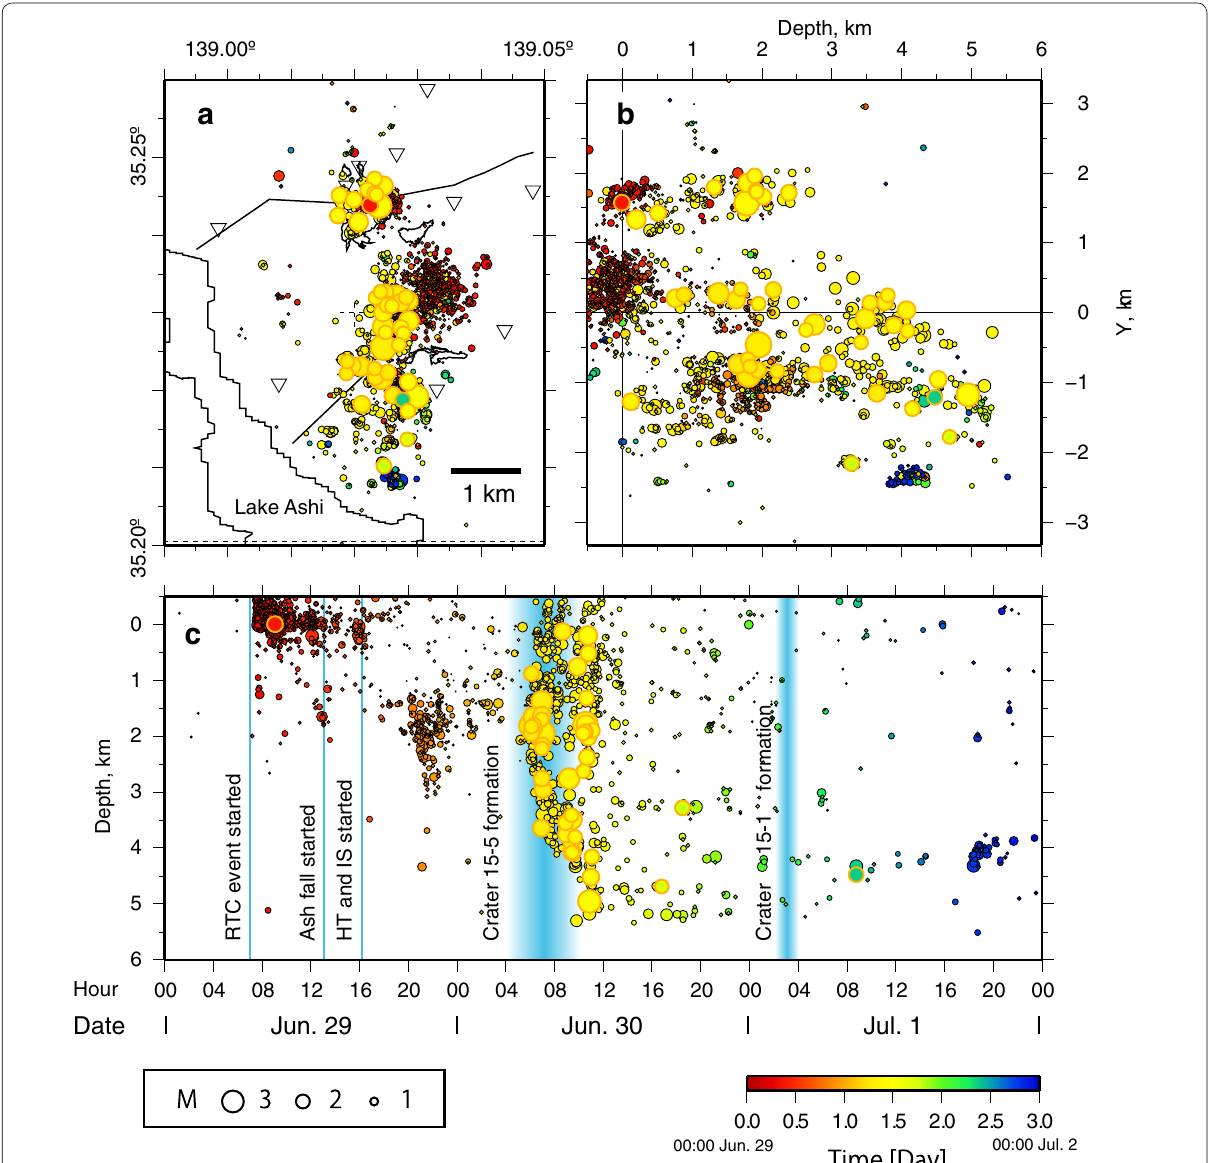
Fig. 16 Seismicity during days of the 2015 eruption (00:00 of June 29–00:00 of July 2). a Epicenter distribution. b Depth distribution along N–S cross section. c Time sequence of seismicity and another geophysical and visual observations. Beginning of rapid tilt change (RTC), ash fall, har- monic tremor (HT) and infrasound (IS) are shown. Timings of crater formations are also